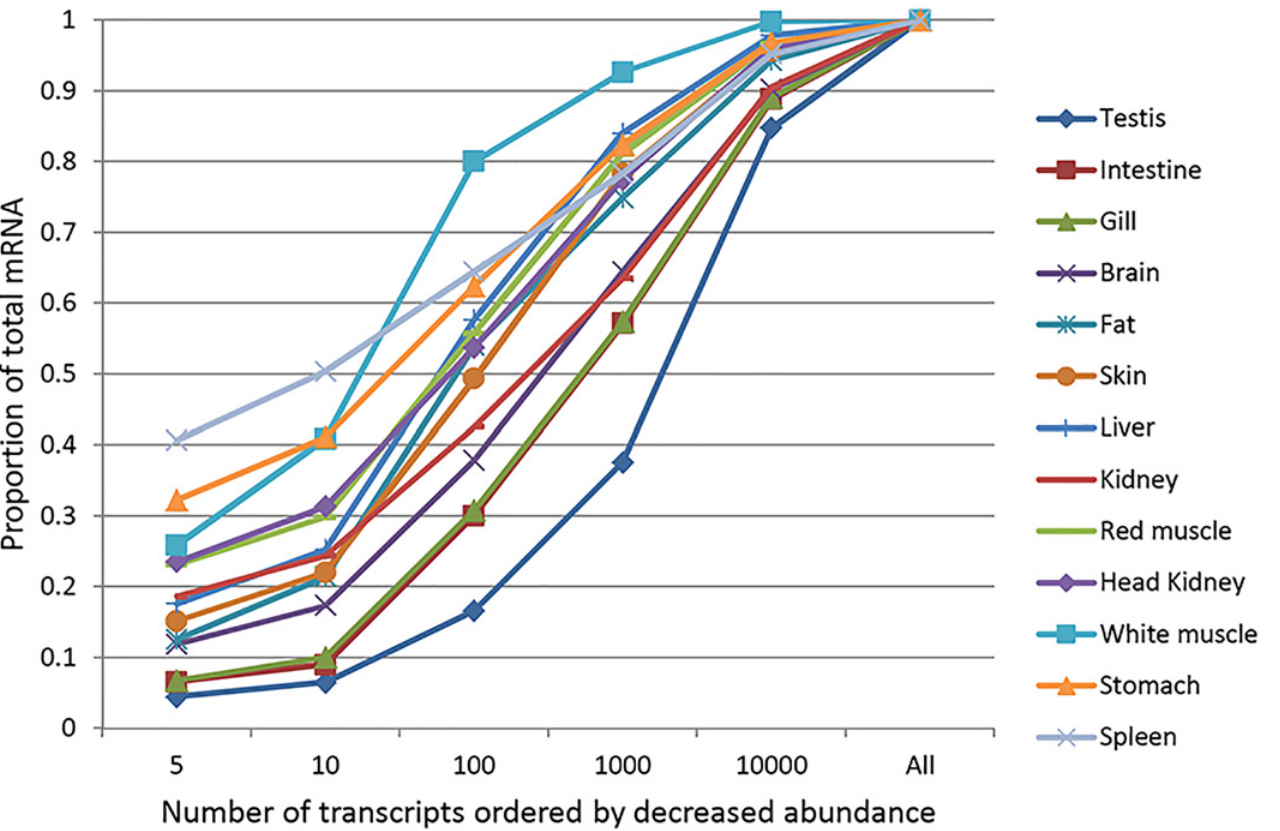
Fig 7. Distribution of gene abundance in various tissues. Proportion of the transcriptome contributed by the most abundant genes is plotted in various tissues. In testis, intestine, gill and brain, there was little contribution of the most highly expressed genes to the mRNA pool. Conversely, in white muscle, spleen, and stomach, a large fraction of the transcriptome was contributed primarily by the most highly expressed